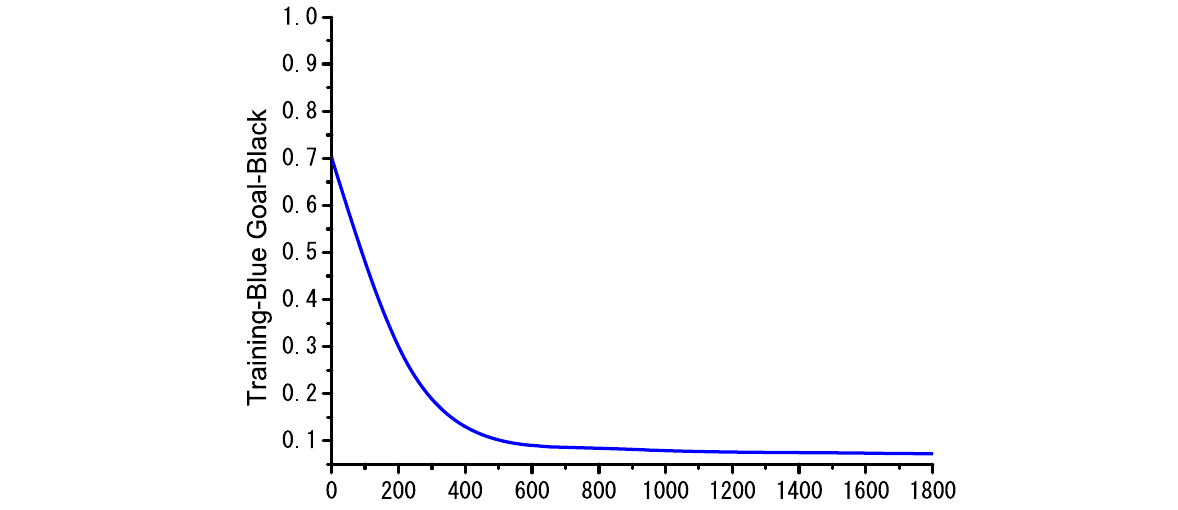
Fig. 6 Gradient descent algorithm convergence graph